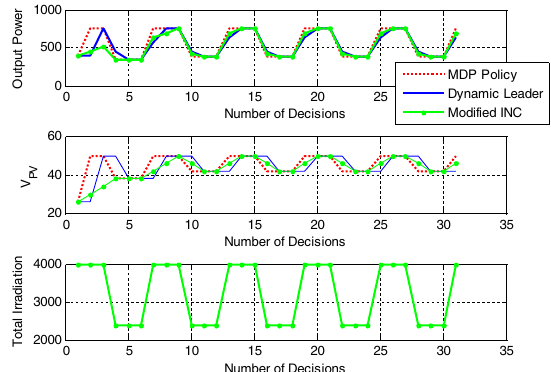
Fig. 9 Irradiance versus photovoltaic voltage under high frequency variations